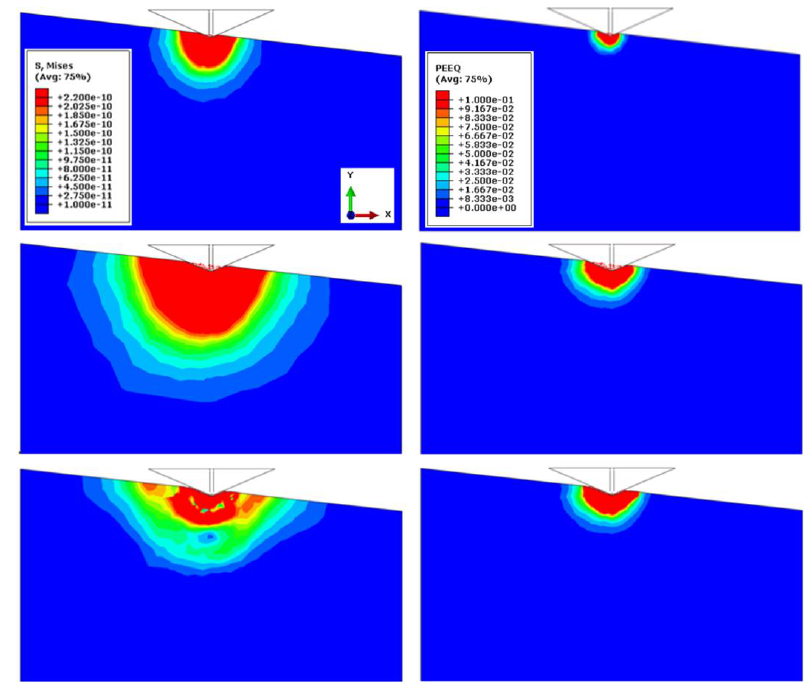
Figure 13. Contour plots of von Mises stress (top), and equivalent plastic strain (bottom) at the center x - y plane of the aluminum block with 6° tilt in the nanoindentation experiment.